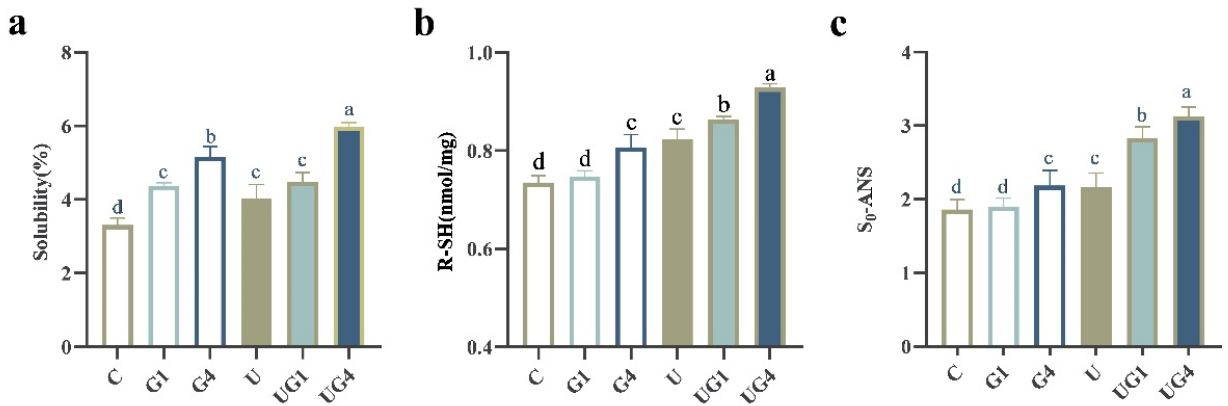
Figure 2. The solubility ( a ), reactive sulfhydryl groups (R-SH) ( b ), surface hydrophobicity (So-ANS) ( c ) under different treatment conditions. a–d means the significant differences ( p < 0.05). C: 3% NaCl; G1: 3% NaCl and 1% glycerol; G4: 3% NaCl and 4% glycerol; U: 3% NaCl with UT; UG1: 3% NaCl and 1% glycerol with UT. UG4: 3% NaCl and 4% glycerol with UT.